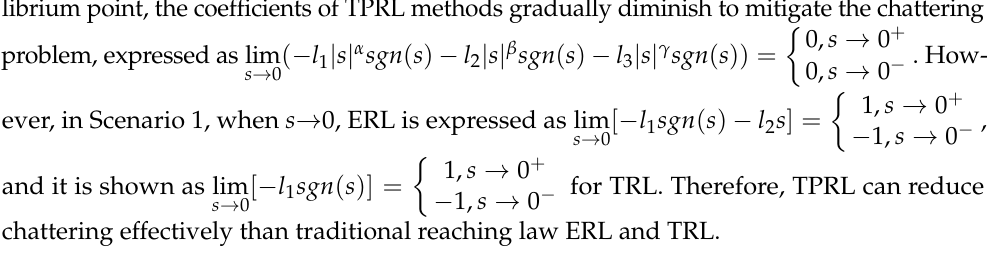
c under reaching